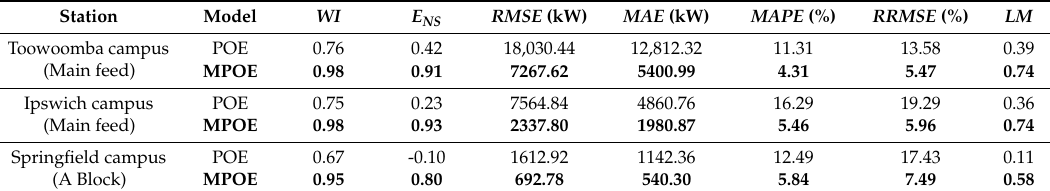
Table 3. Optimum model performance in the testing phase for daily forecast horizon based on Willmott’s